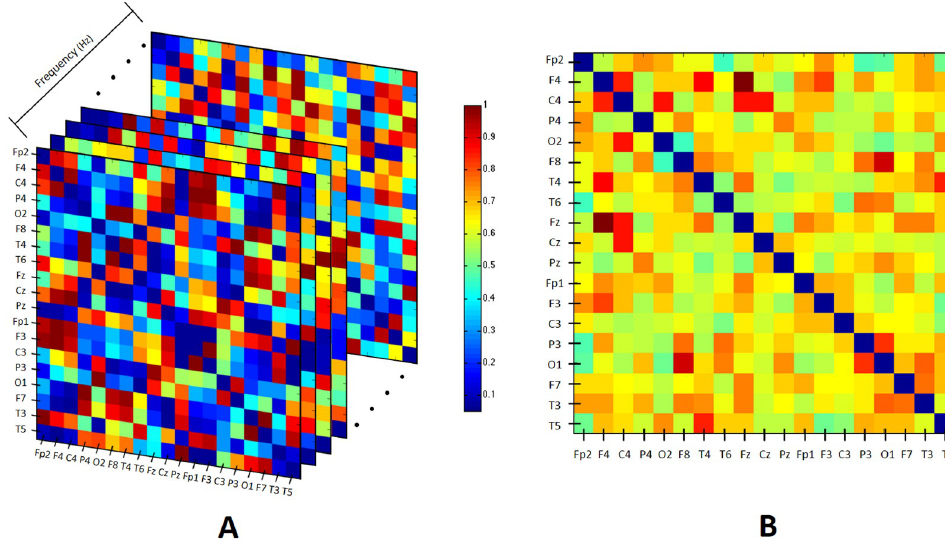
Fig 3. An example of the coherence spectrum matrix for one HA participant is shown in A, while B depicts the average coherence matrix that resulted from the coherence spectrum matrix integration from 0.5–30 Hz.